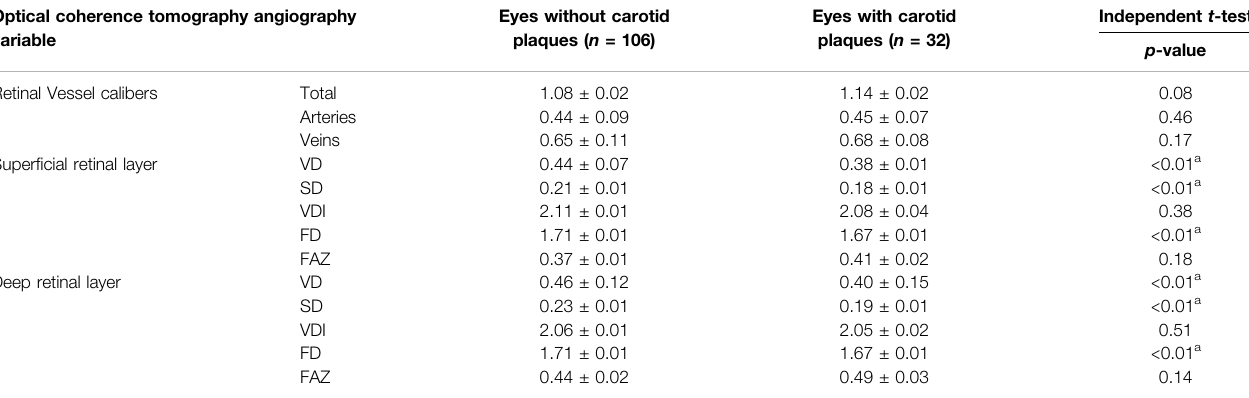
TABLE 5| Quantitative analysisand comparisonswithanindependent t -test ofopticalcoherence tomographyangiography-derived databetweengroups withtheabsence or presence of carotid plaques. Optical coherence tomography angiography